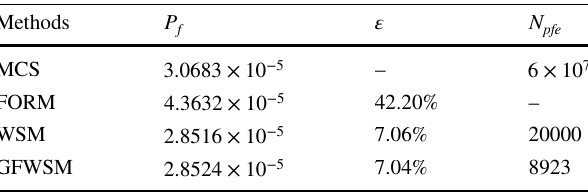
Table 4 Estimated failure probability, relative error and the number of performance function evaluations of different methods on reliabil- ity analysis example 2 Methods